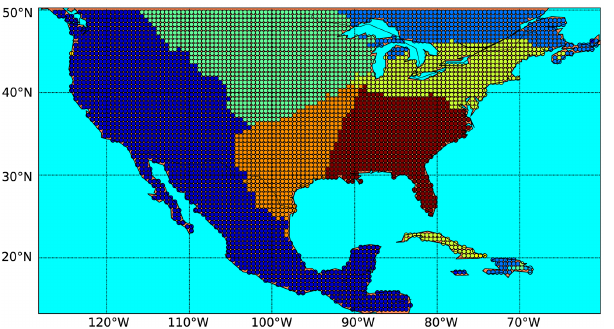
Figure 5. Boundaries of the communities obtained from the climate networks. Note that the largest community coincides with a regular relief